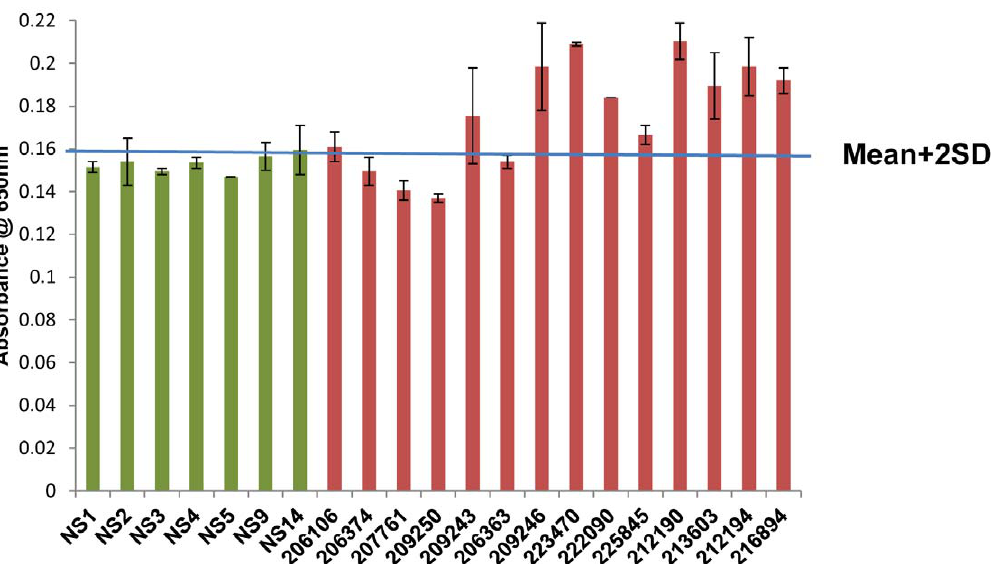
Figure 6. Analysis of clinical samples. The clinical samples were analysed in the microtitre plate. The line in the middle showed the cut-off point that was chosen to be mean + 2 SD (standard deviation). The green bars (with alphanumeric sample number) showed the negative samples, all of which lied below the line. The red bars (with numerical sample number) showed the positive samples, nine of which were above the line.